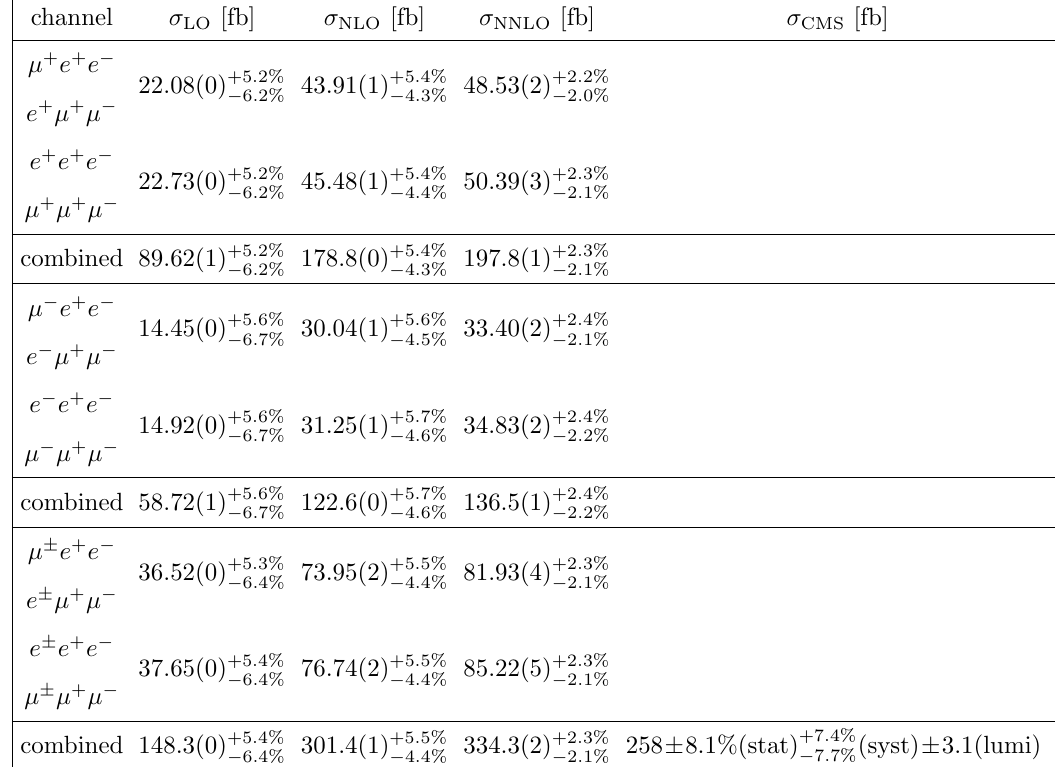
Fiducial cross sections for CMS 13 TeV. Note that due to the (cid:13)avour-unspeci(cid:12)c lepton cuts the theoretical predictions are (cid:13)avour-blind, which is why the results are symmetric under e (cid:22) exchange. The available CMS data from refs. [8] are also shown. \Combined" refers to the $ sum of all separate